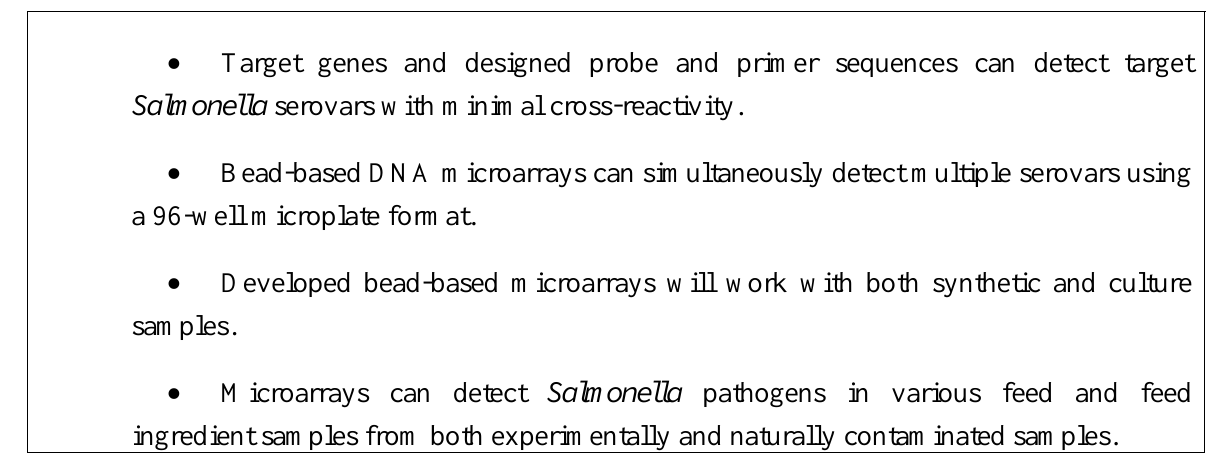
Table 1. Criteria for optimal DNA bead-based microarray